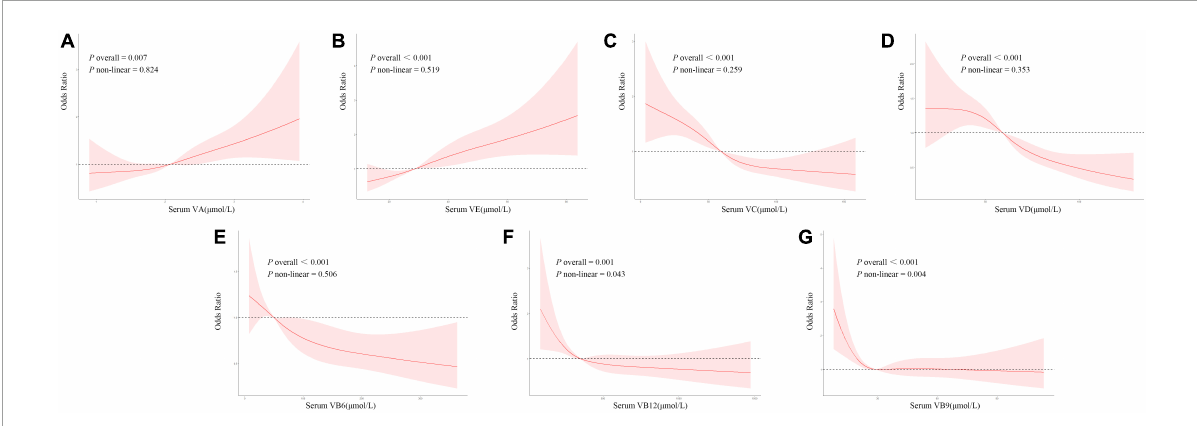
FIGURE3 (A–G) Dose–response relationships between serum vitamin levels and the risk of NAFLD with restricted cubic spline model. The model was adjusted for gender, age, ethnicity, FIPR, education level, and disease history (hypertension, high cholesterol, and